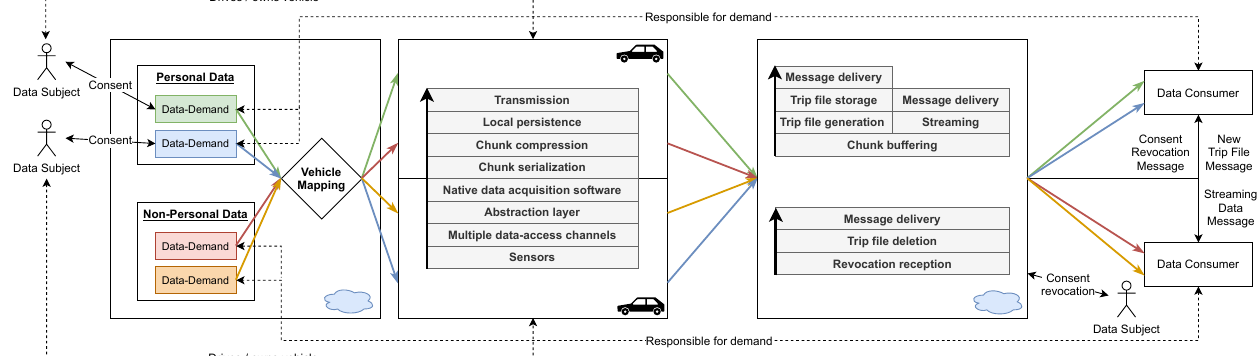
Figure 1. Use of our system to acquire personal and non-personal